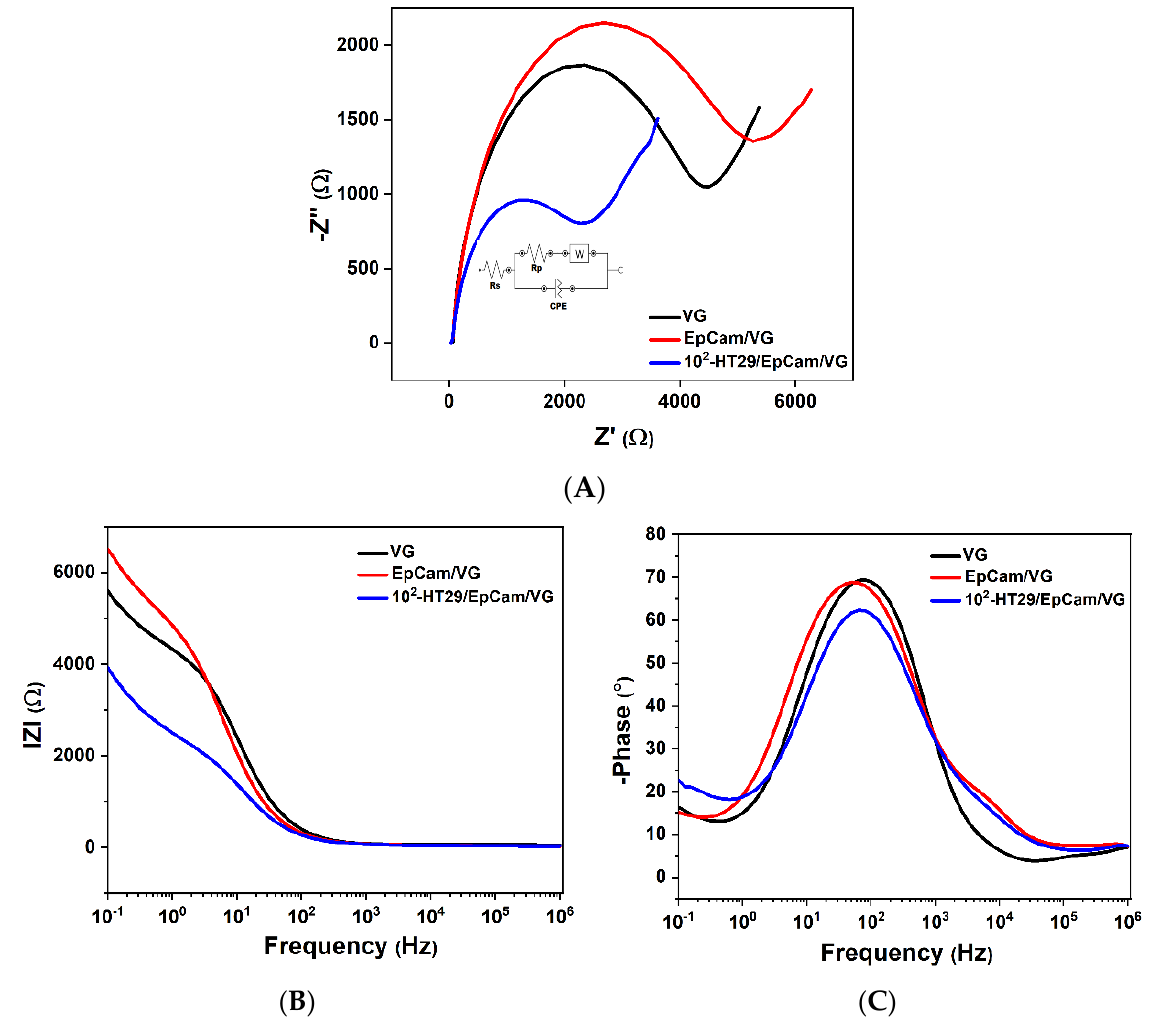
Figure 8. ( A ) Nyquist diagram; ( B , C ) Bode diagrams of VG: sensor blank, EpCam/VG-based sensor and sensor after capturing 100 cell mL −1 concentration of HT-29 cells from 0.1 to 10 6 Hz in PBS solution containing 1 mM [Fe (CN)6]3 − /4 − and 0.1 M KCl.